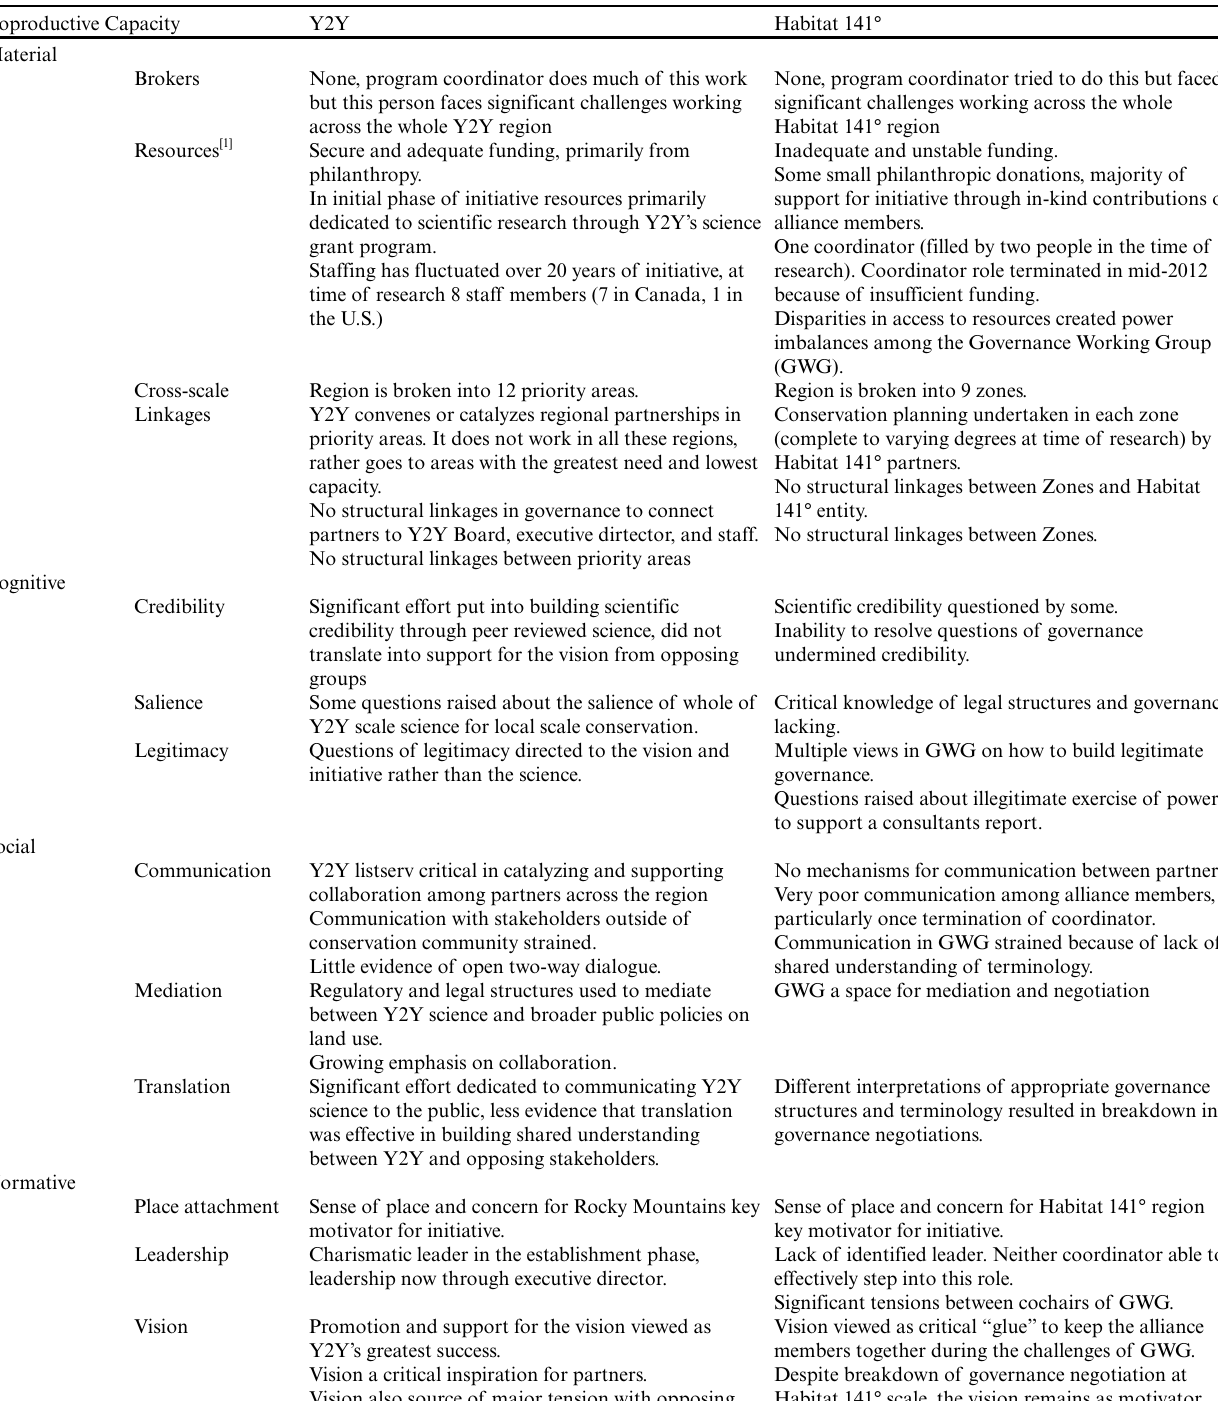
Table 2 . Summary of interview data in relation to coproductive capacities